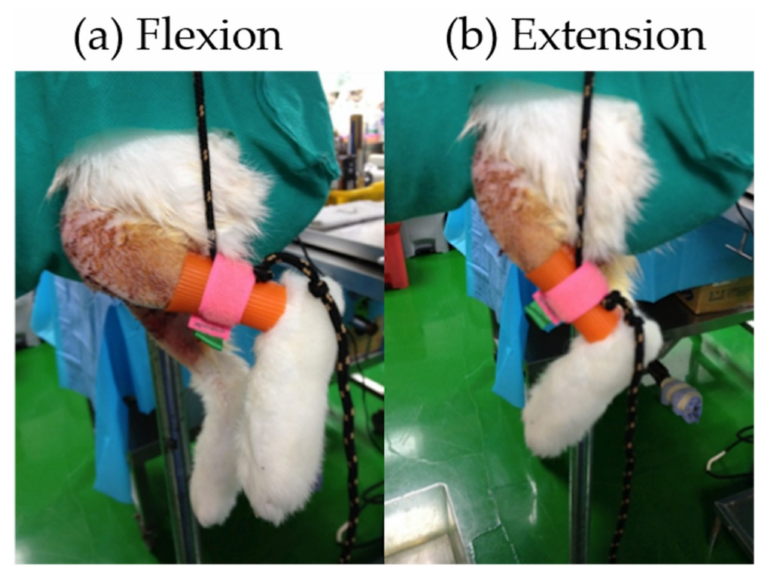
Figure 8. Short-term CPM treatment. ( a ) Flexion ( b )